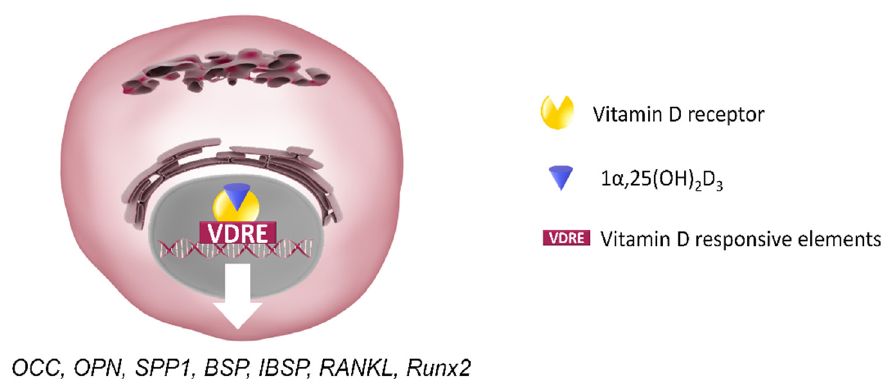
Figure 5. Scheme of direct actions of 1,25(OH)2D3/VDR on mature osteoblasts. 1,25(OH)2D3 acts via the VDR to regulate the osteoblast-related genes containing VDRE binding motifs. 1,25(OH)2D3 can both positively and negatively regulate expression of osteoblast phenotypic markers as a function of the proliferative and differentiated states of osteoblasts and the duration and concentration of exposure. SPP1, Secreted Phosphoprotein 1; BSP, bone sialoprotein; IBSP, integrin binding sialoprotein.